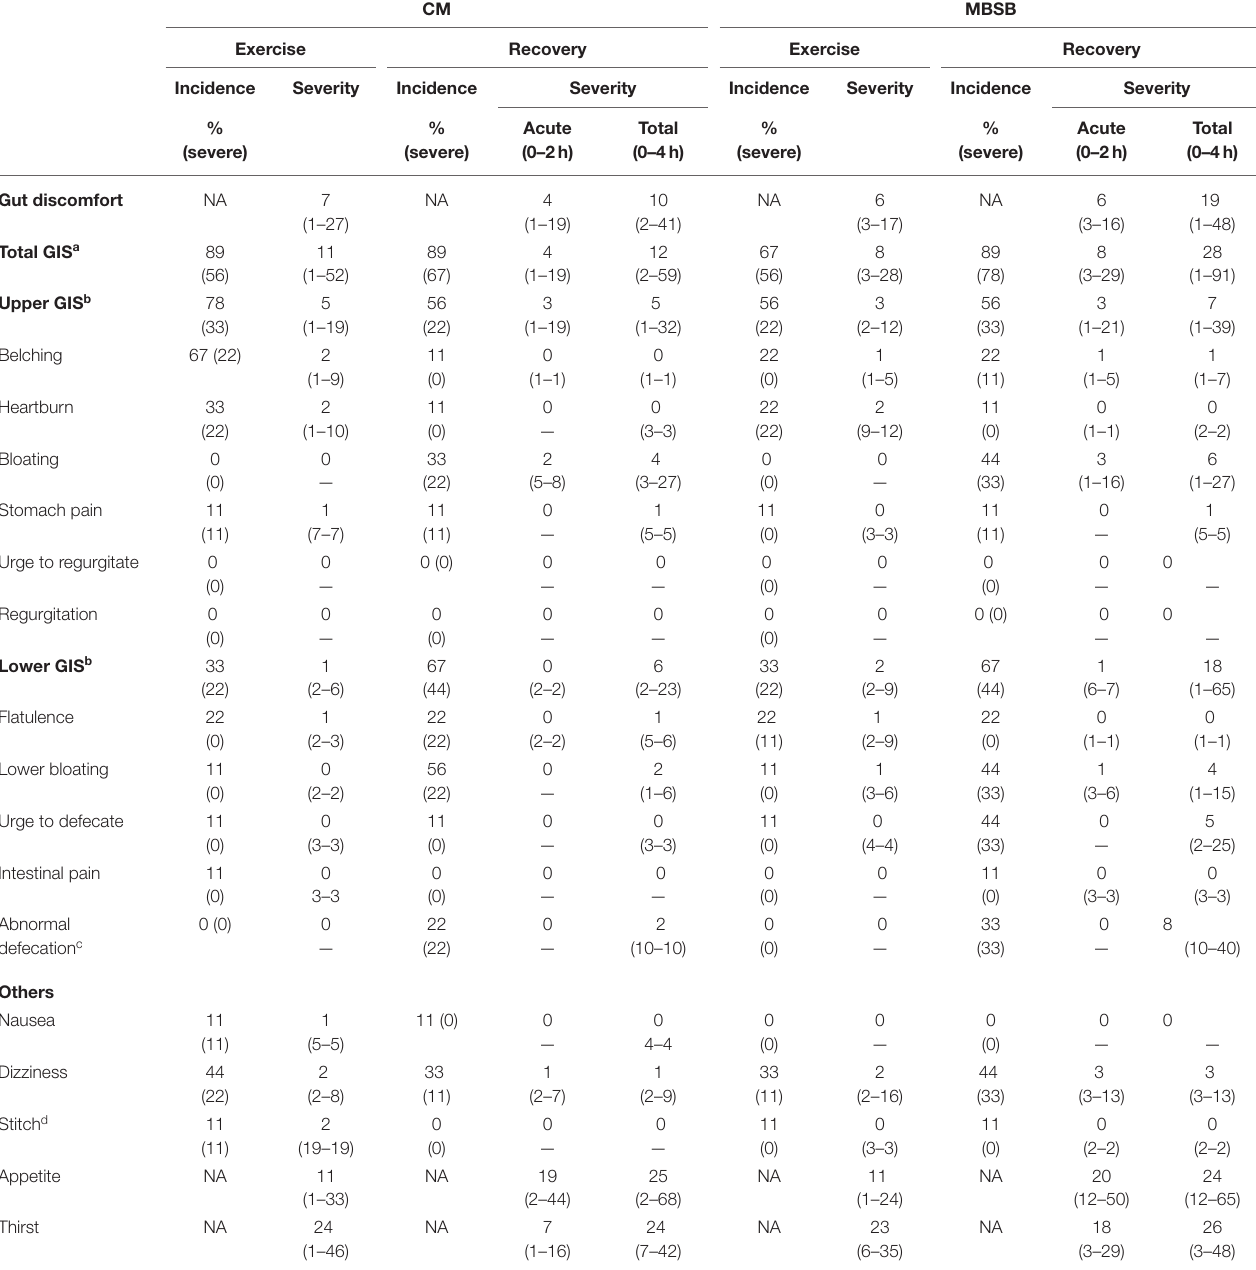
TABLE 2 | Incidence of gastrointestinal symptoms and severity of gut discomfort, total, upper-, and lower-gastrointestinal symptoms in response to 2h HIIT exercise (between 60 and 80% V O 2max ) in temperate ambient conditions and after consumption of a whole food dairy milk beverage (CM) and a reconstituted milk based supplement beverage